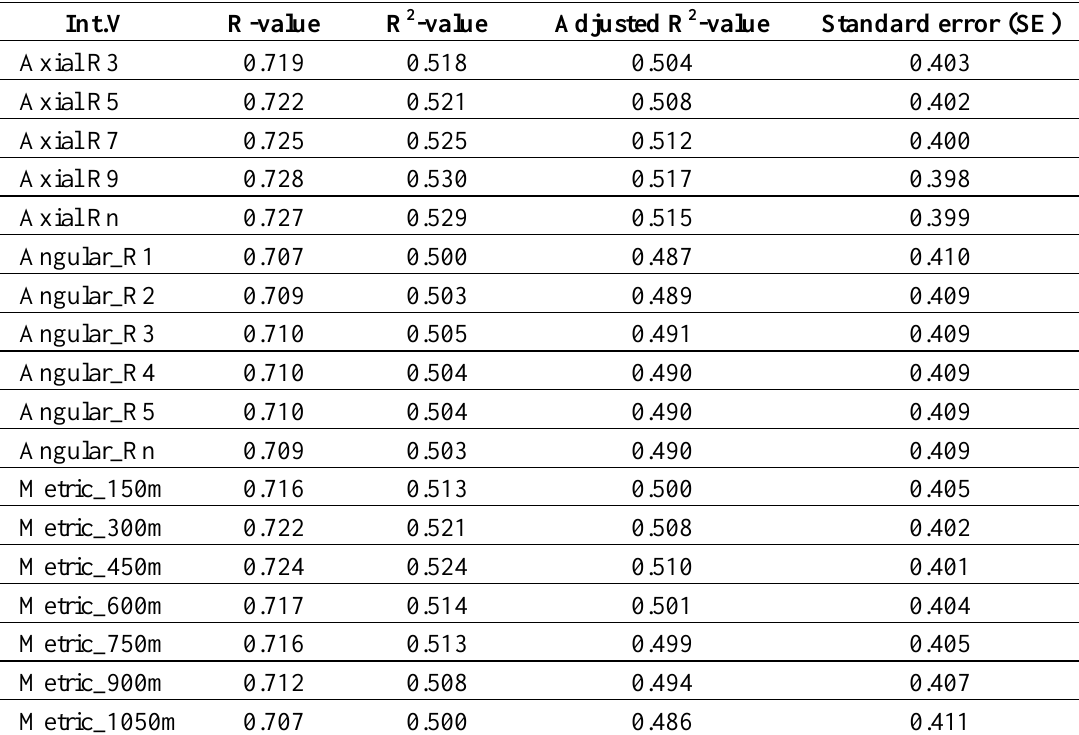
Table 4. Distribution models using each value of Int.V.